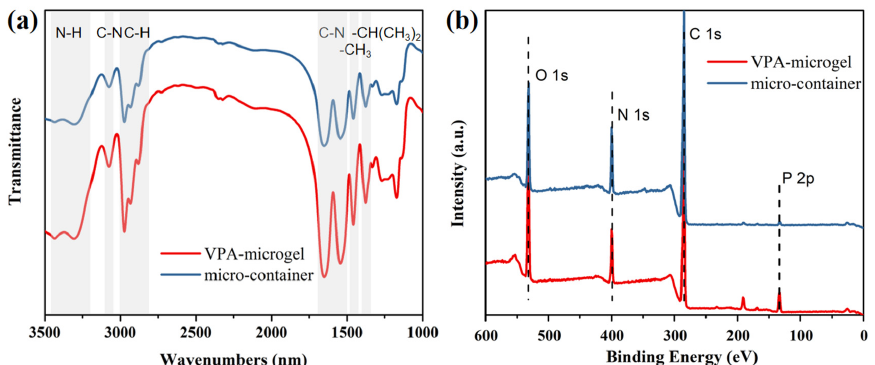
Figure 3. IR spectrum ( a ) and XPS diagram ( b ) of VPA-microgels (red line) and micro-container (blue line).